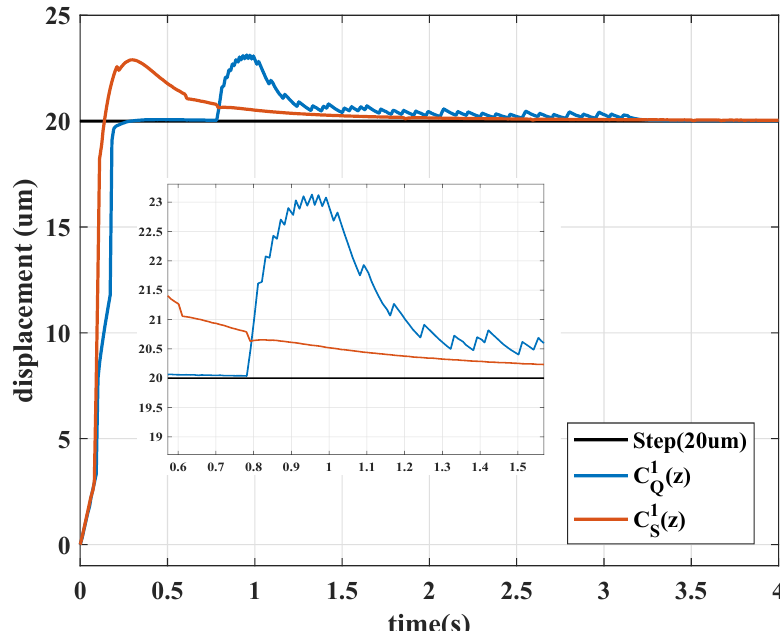
Figure 5. Step responses with p t =